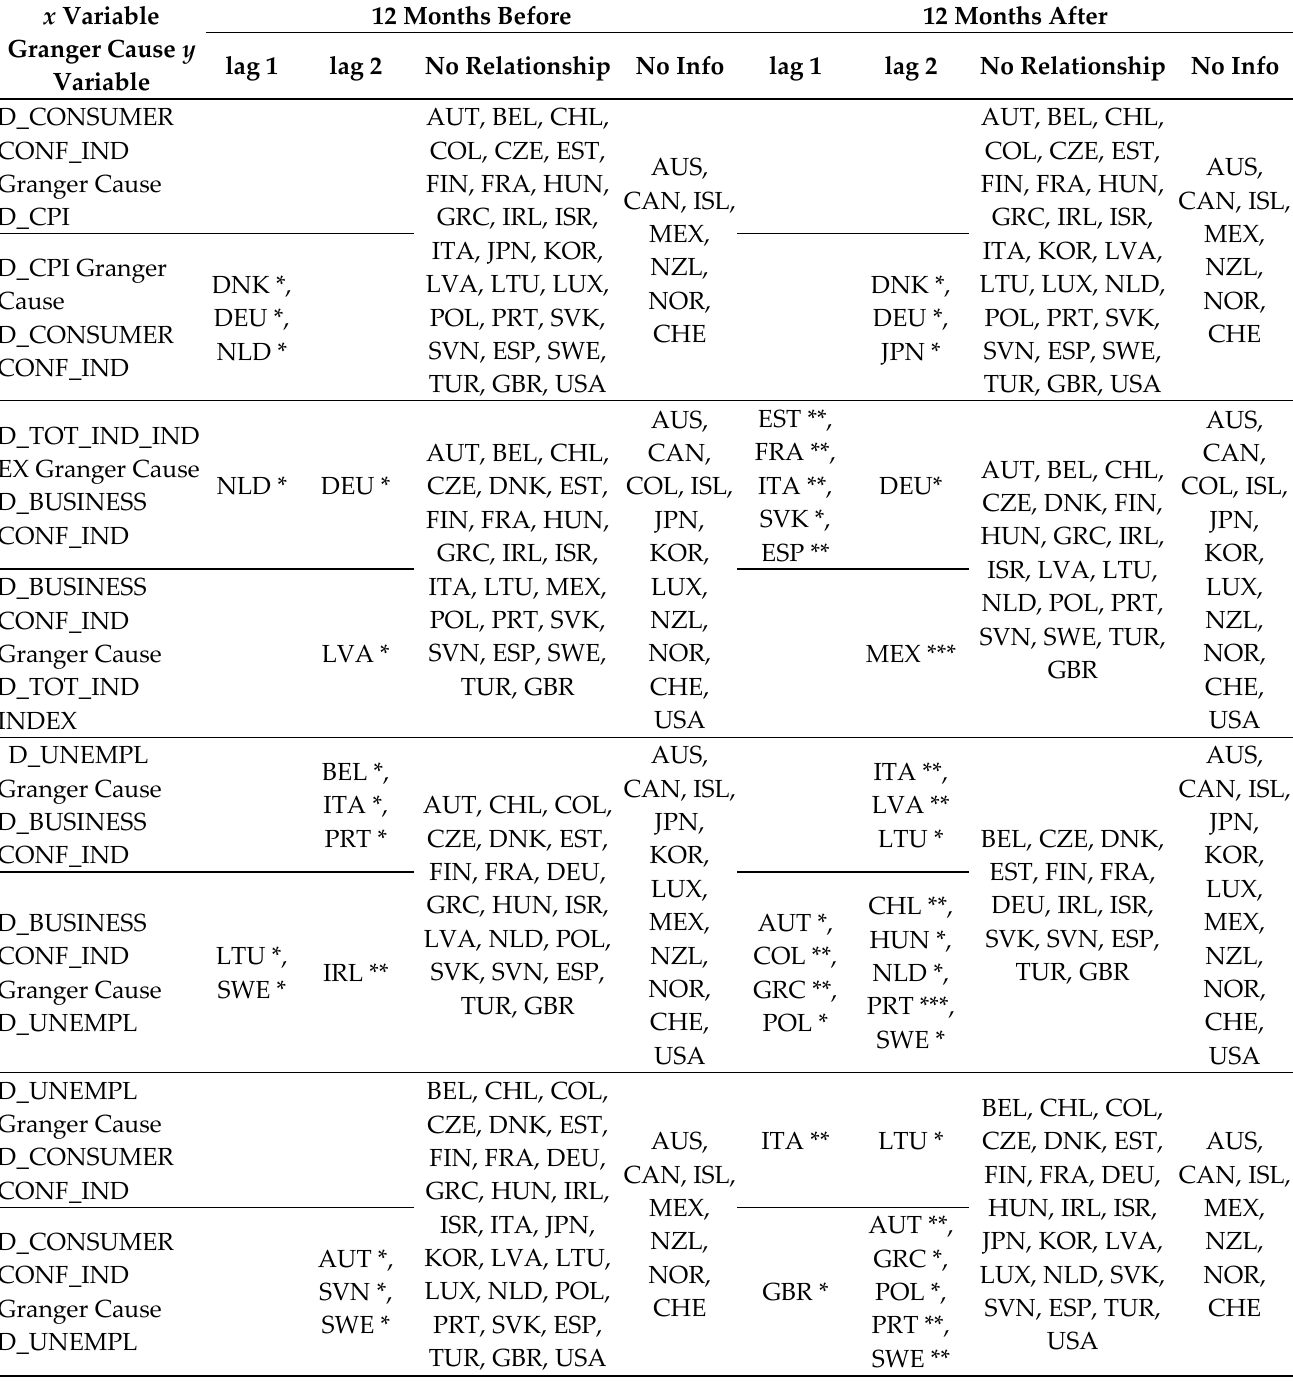
Table 3. Generalized results of calculations according to the Granger Causality test.